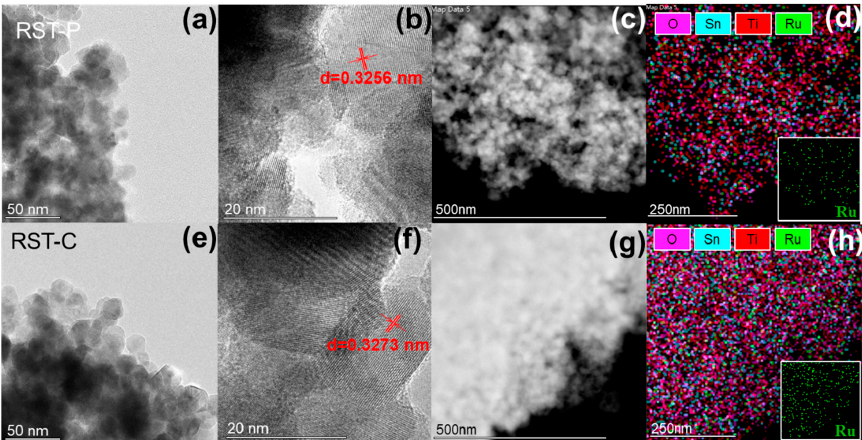
Figure 3. TEM images of ( a ) RST-P and ( e ) RST-C. The interplanar crystal spacing measured from